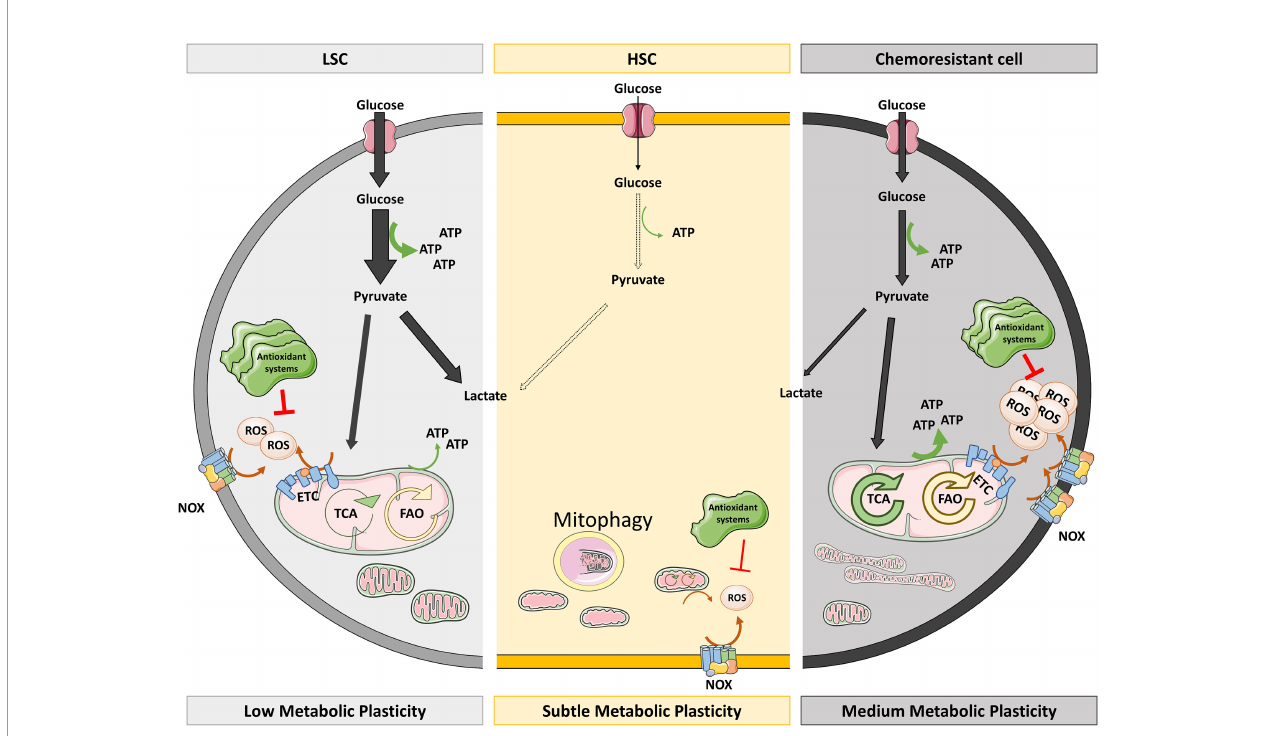
FIGURE 1 | Redox and metabolic status of HSC versus LSC and chemoresistant cells. HSC are characterized by low metabolic activity and ROS levels. The low ATP levels they need come from glycolysis as they have immature mitochondria which suffer mitophagy. Low NOX levels and mitochondrial metabolism could explain the low ROS levels of HSC, which do not require high antioxidant systems to keep them under control. However, LSC actively obtain energy mainly by glycolysis (thick arrow) but also from TCA and FAO (thin arrows). This active metabolism provokes the production of ROS that are quenched by overexpressed antioxidant systems. On the right side of the fi gure, chemoresistant cells also produce ATP by glycolysis although they show mature and fused mitochondria which render high OXPHOS, being fed by hyperactivated TCA and FAO. Augmented OXPHOS and NOX result in high ROS levels which cannot be extinguished despite high antioxidant systems. ETC, electron transport chain; FAO, fatty acid oxidation; HSC, hematopoietic stem cells; LSC, leukemic stem cells; NOX, NADPH oxidase; OXPHOS, oxidative phosphorylation; TCA, tricarboxylic